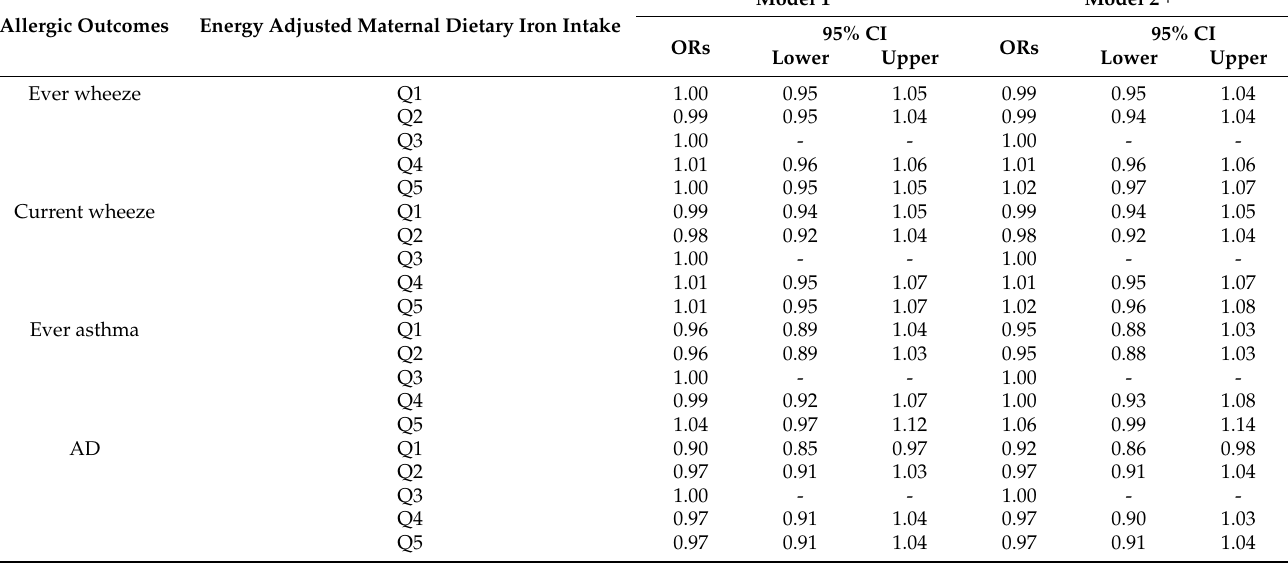
Table 3. Association of energy adjusted maternal dietary iron intake with allergic outcomes among all selected children at age 3